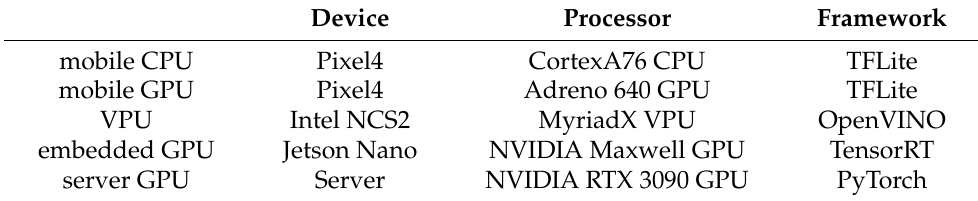
Table 1. Evaluated hardware